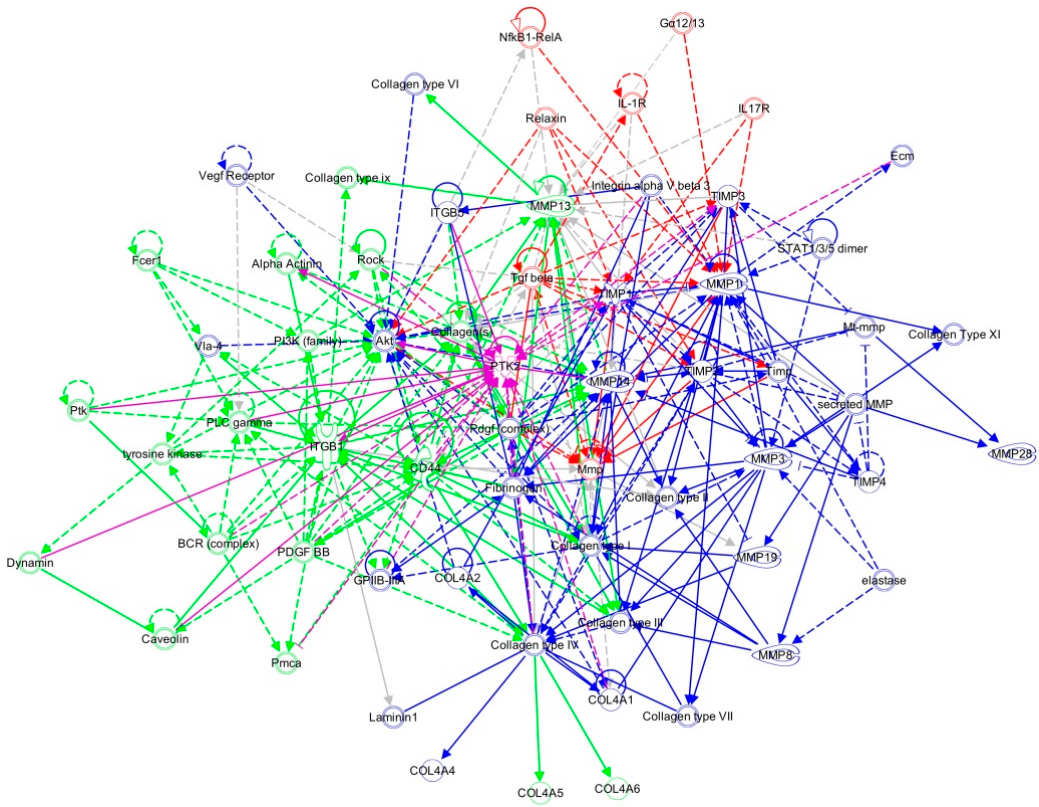
Figure 5. Merged network analysis of keratinocyte subpopulations. Merged network analysis of the three clusters in Figure 4. The top scoring networks generated from genes significantly up-regulated in each of the three keratinocyte subpopulations (cluster 1 (red), cluster 2 (green), and cluster 3 (blue)) were merged using Ingenuity Pathway Analysis (IPA), creating a super-network centered on the FAK-AKT-PI3K axis. Known relationships among molecules across the original three networks are represented in magenta. * denotes FAK (PTK2).